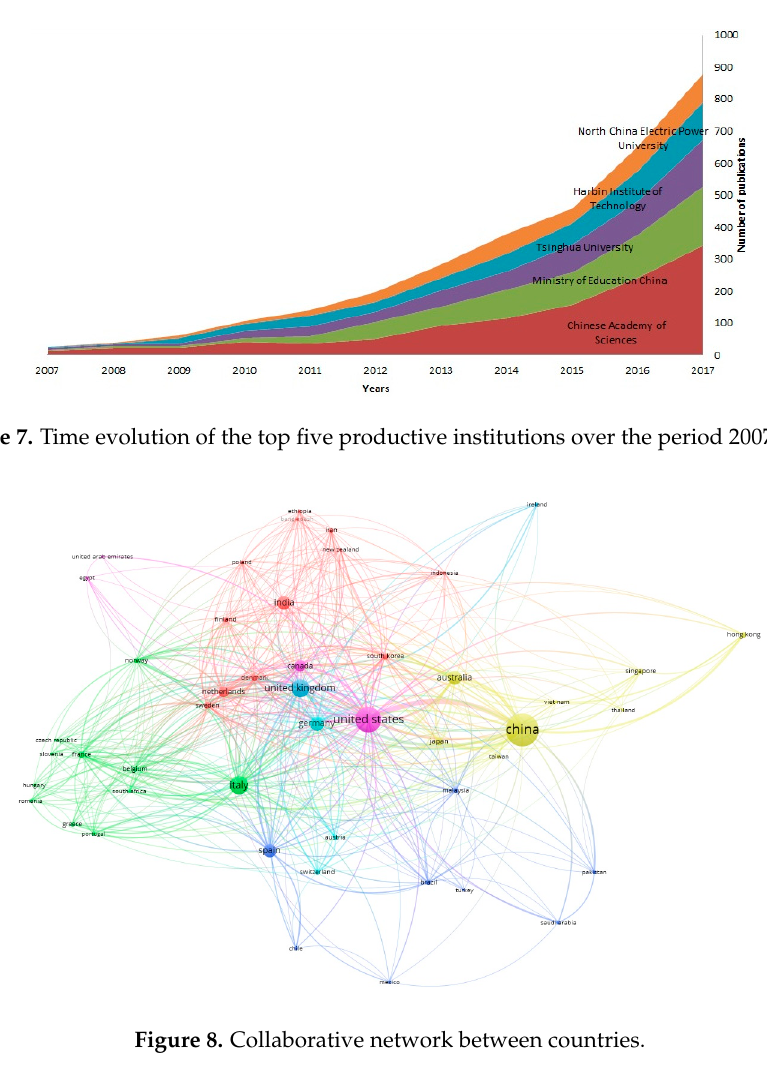
Figure 9. Publication distribution by subject area, according to Scopus.